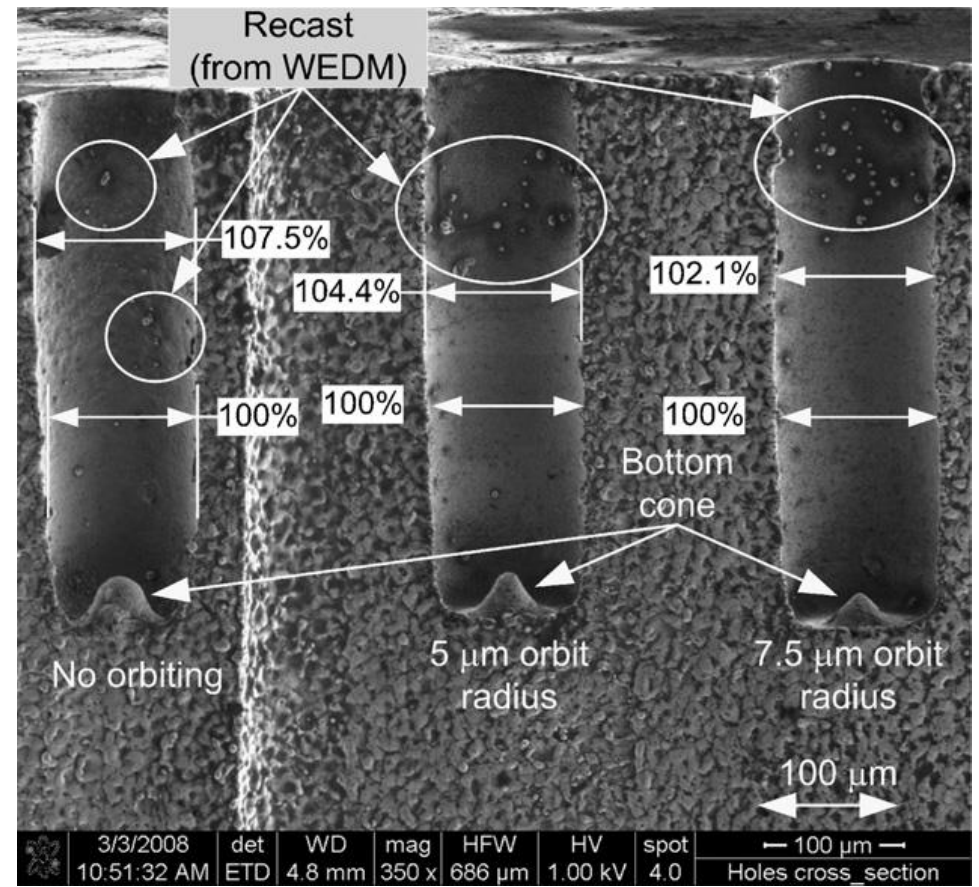
Figure 20. Cross-section of 500 µm deep micro-holes without orbiting; with 5 µm orbit radius; and with 7.5 µm orbit radius drilled with 60 V and 47 pF capacitance [182].